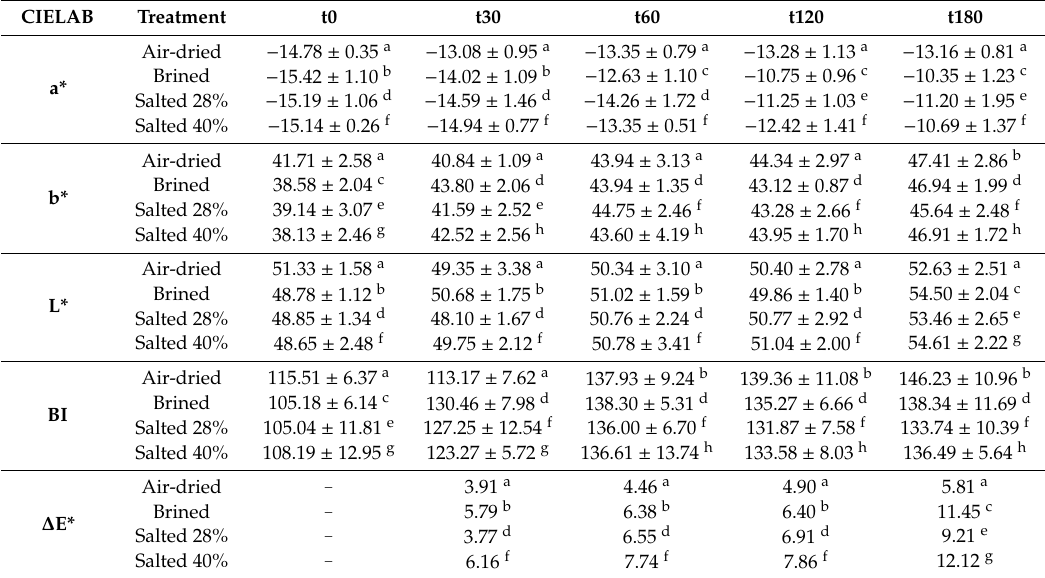
Table 2. Surface color parameters of Ulva rigida submitted to di ff erent preservative processes (air-drying, brining, salting at 28% and 40%), over six months of